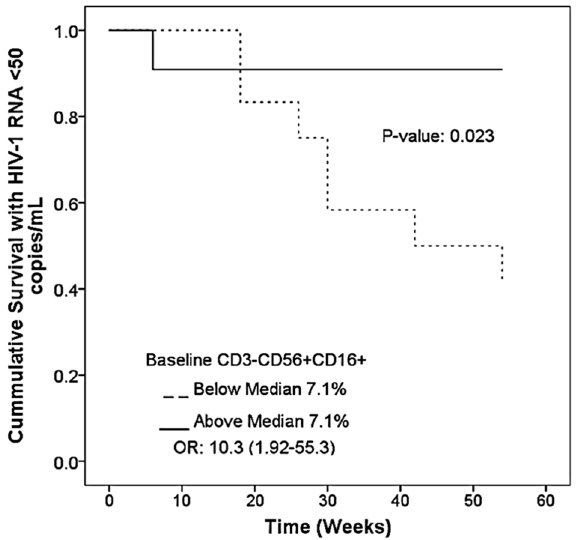
Figure 2. Proportions with HIV-1 RNA , 50 copies/ml after regimen simplification by baseline NK cell levels. Figure 2 shows a Kaplan-Meier plot for the survival with HIV-1 RNA level above 50 copies/mL during the A5201 study based on the participant’s NK cell level at study entry. The p-value is 0.023 by Kaplan-Meier analyses for the difference at 54 weeks between the groups above and below the median NK cell level.